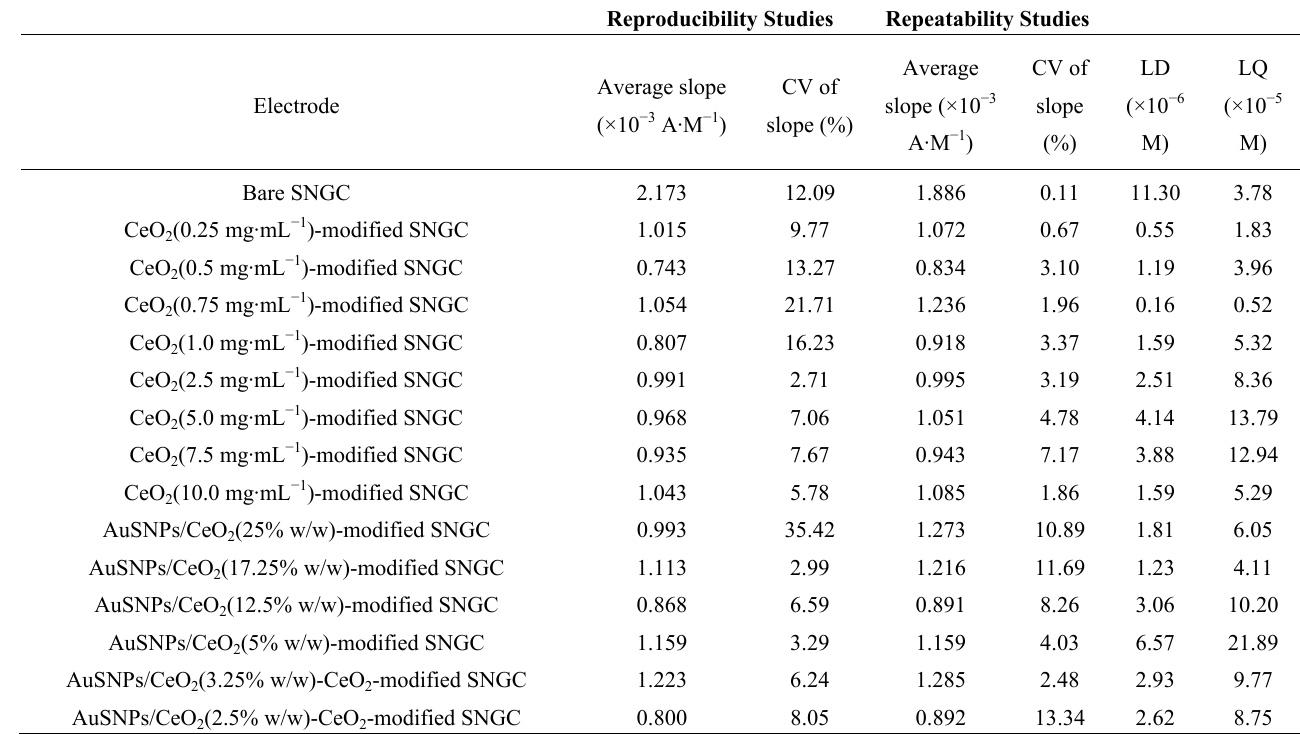
Table 3. Results obtained for the reproducibility and repeatability studies by using three different SNGC electrodes and the same SNGC electrode (with at least three different calibration curves for each electrode), respectively, and the best detection and quantification limits for each one of the configurations